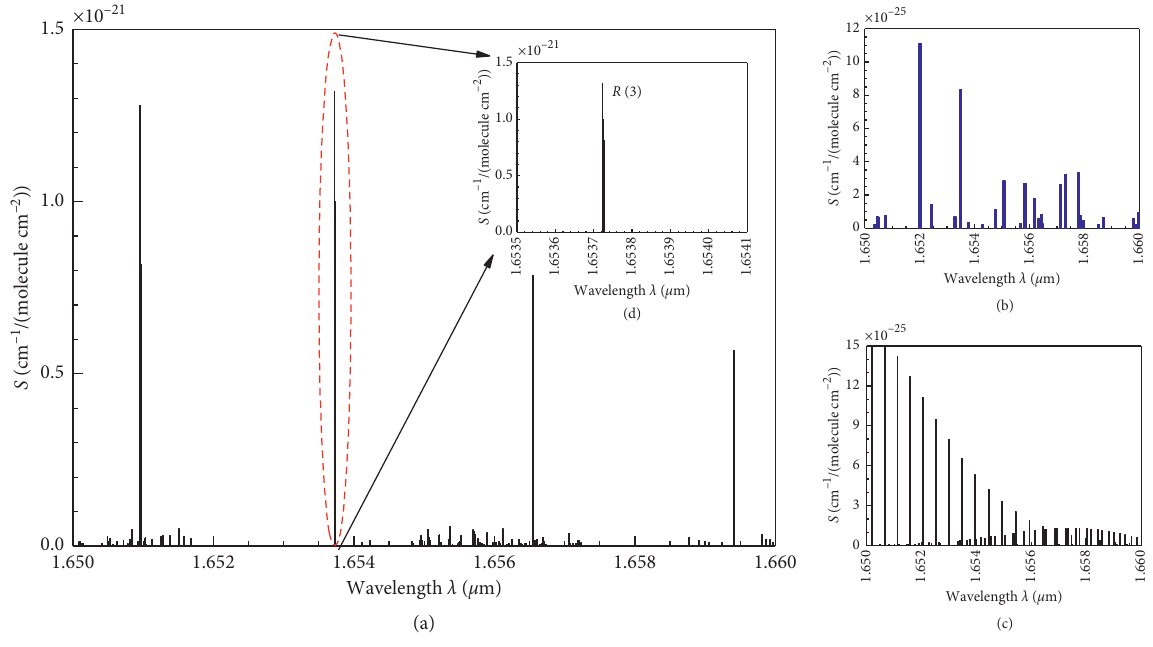
Figure 1: Absorption line selection and comparison among CH